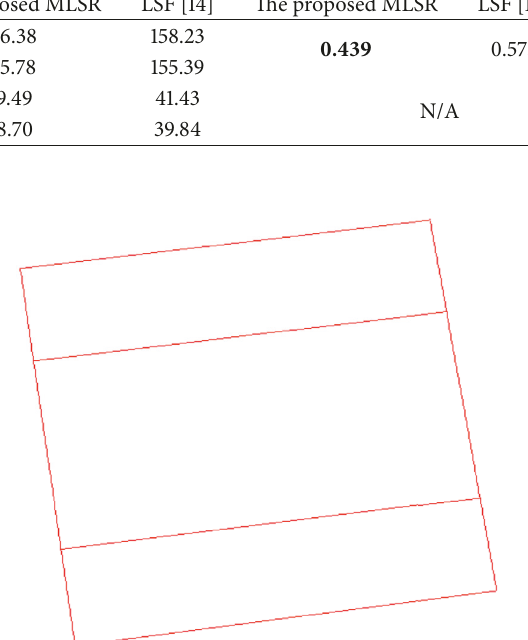
Figure 10: Edge estimation result under gray